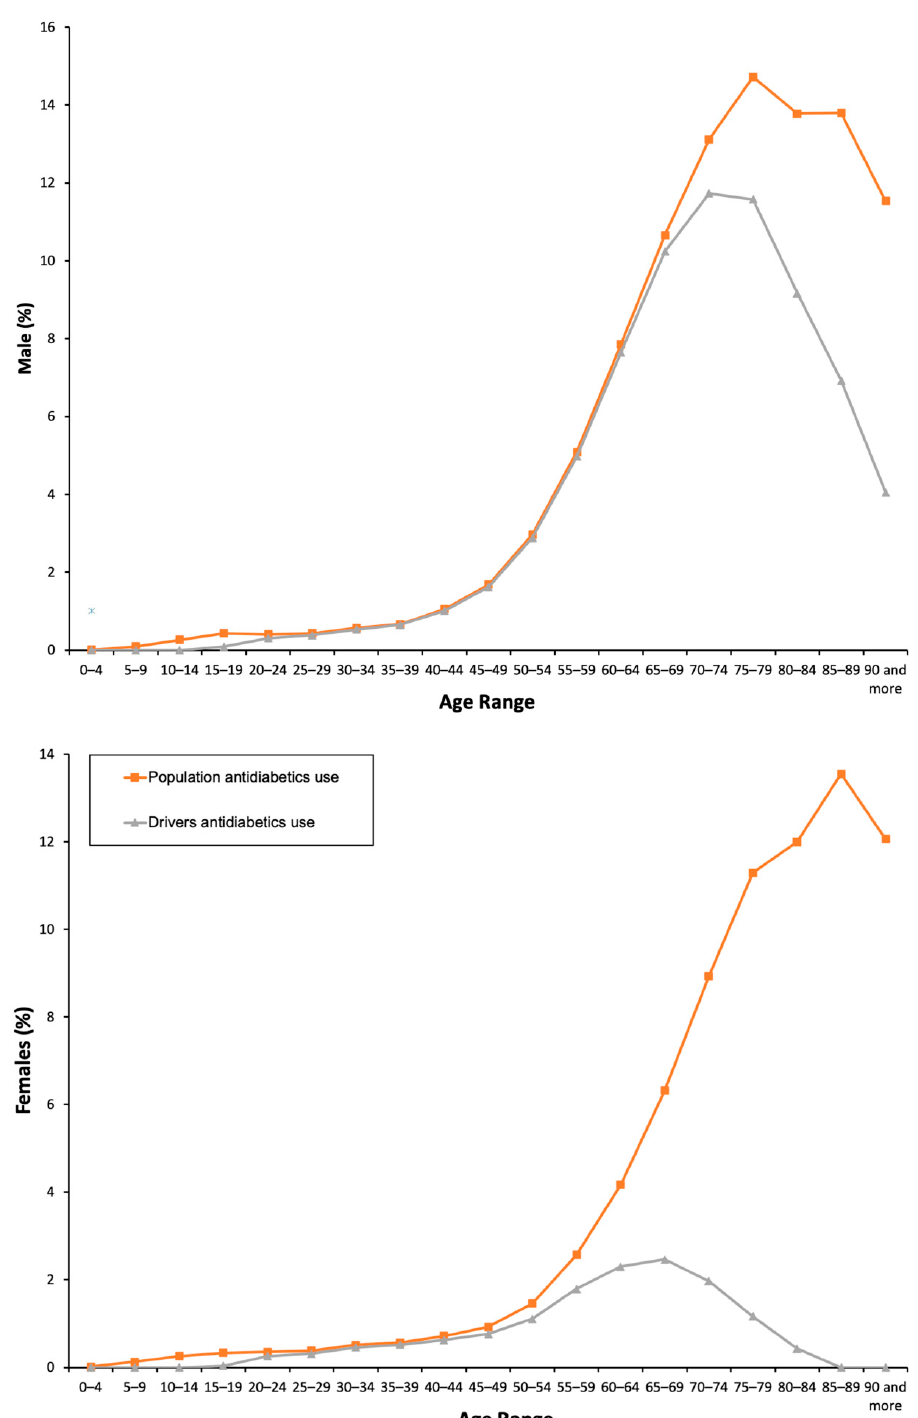
Figure 1. Frequency of antidiabetics use by the general population and the driver population.